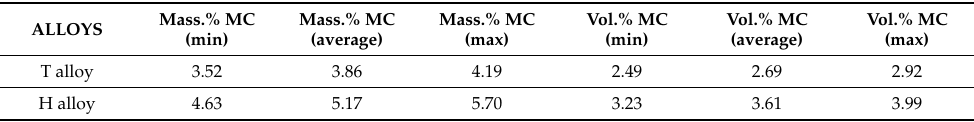
Table 7. Mass and volume fractions of the MC carbides in the two alloys after exposure at 1250 ◦ C for 50